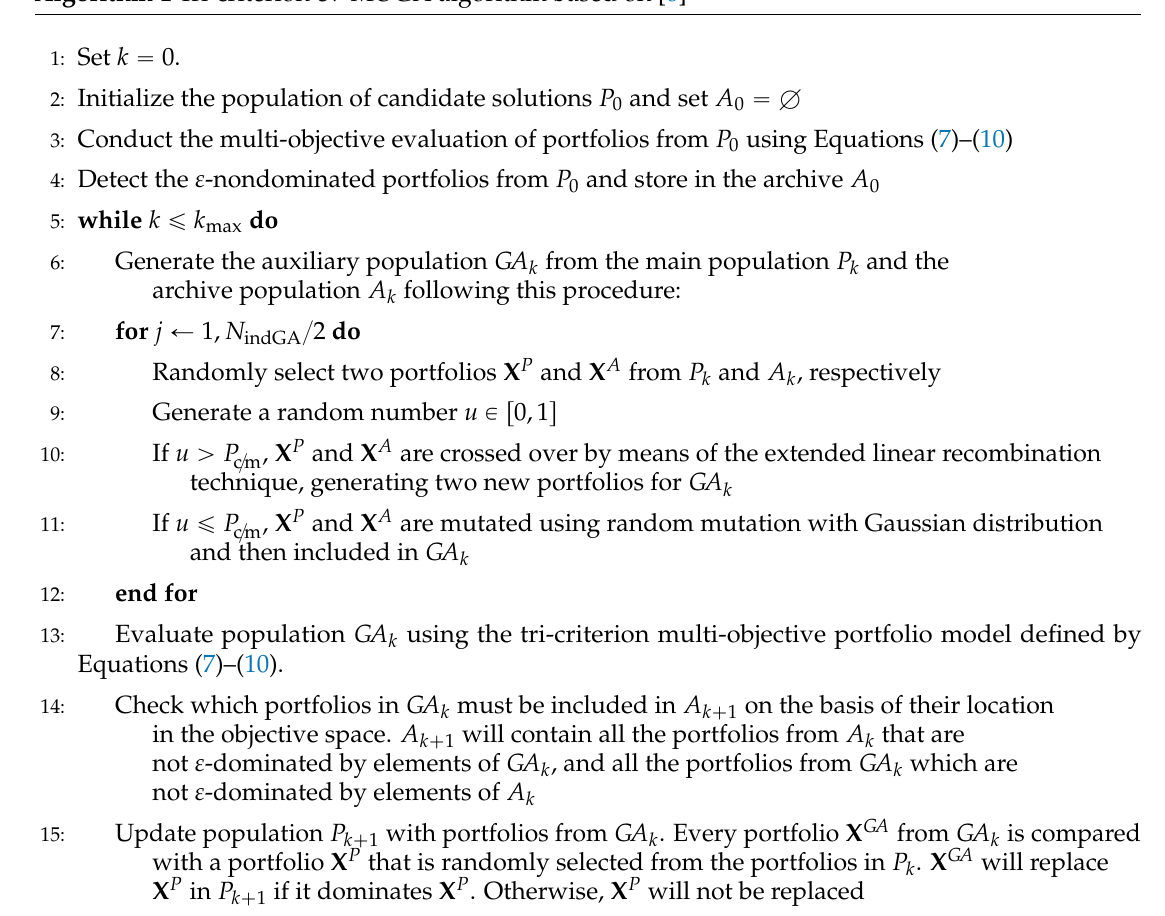
Algorithm 1 Tri-criterion ev-MOGA algorithm based on